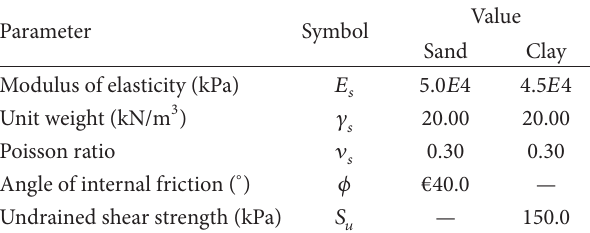
T 3: Elastic-plastic properties of